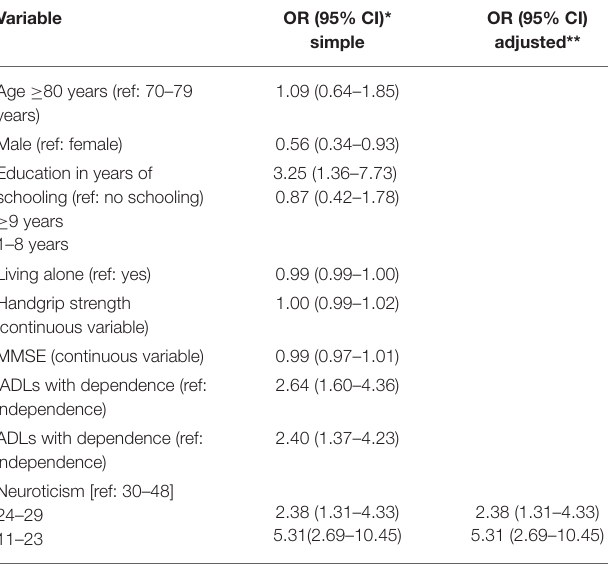
TABLE 3 | Results of simple and multiple logistic regression analyses for self-rated health as “good” or “very good” in the Brazilian sample. Variable